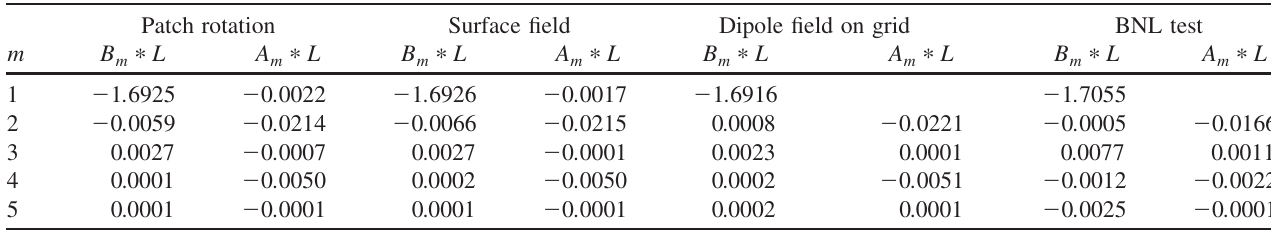
TABLE II. Integrated ELS harmonics in T-m from various